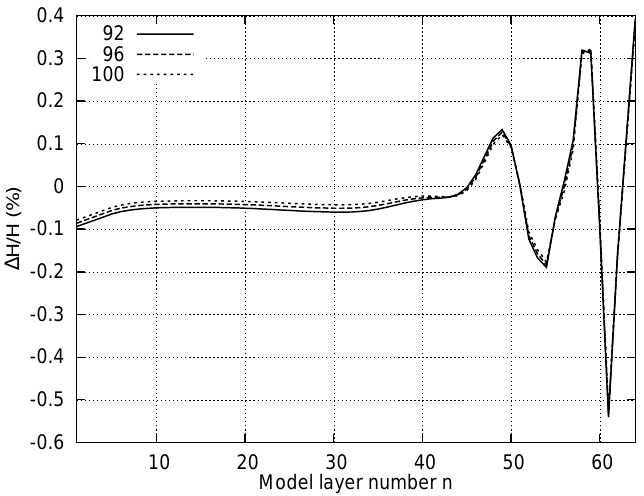
Fig. 1. A typical picture of the final relative precision of the radiative flux obtained using the Uns¨old-Lucy correction method (in %). As argument values in all Figures the model layers, numerated starting from outside, are given. Model parameters: T eff = 10 750 K, log g = 4. The legend inside the frame gives the iteration